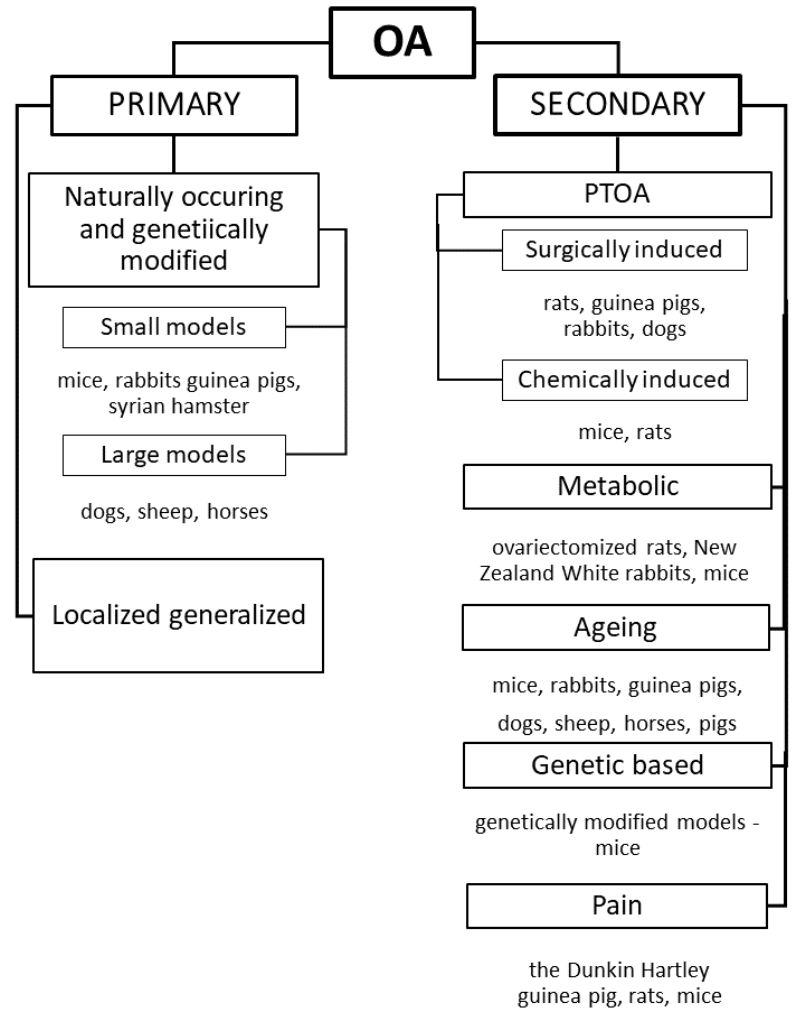
Figure 2. Osteoarthritis classification and